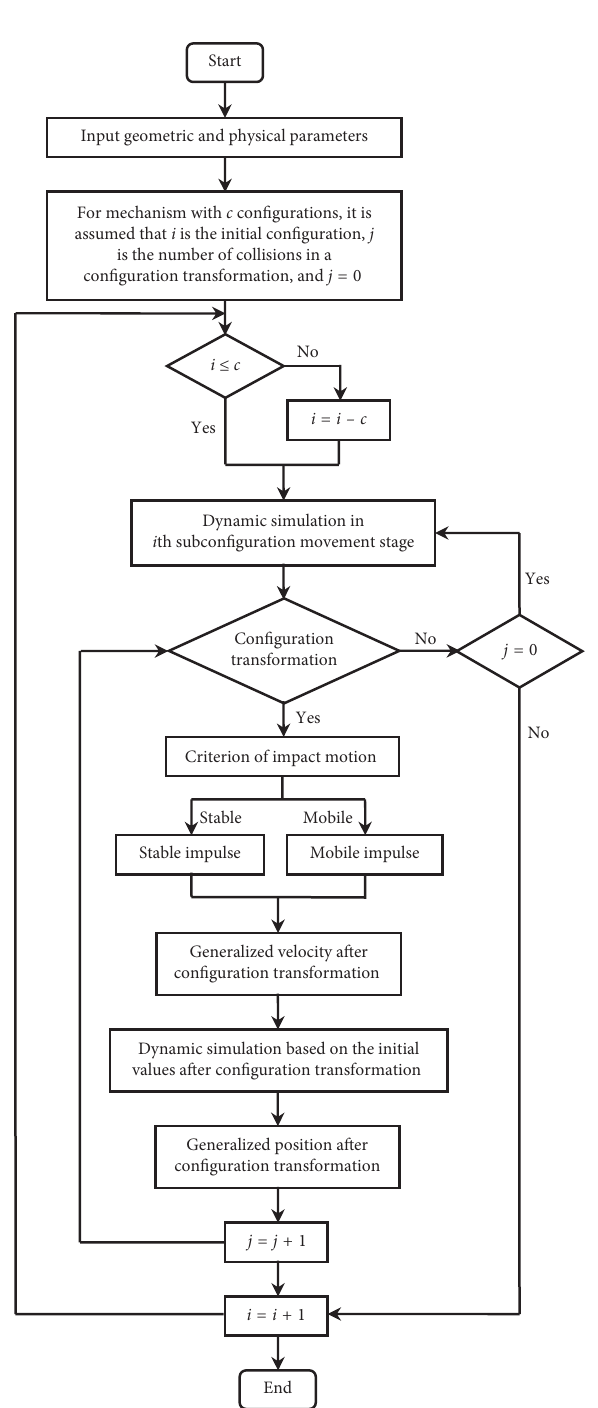
Figure 3: The flow graph of numerical